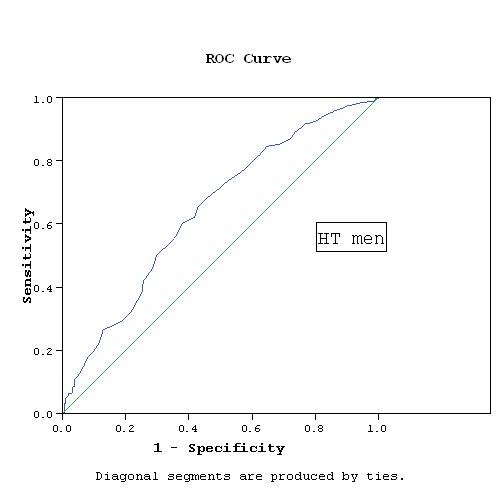
WC cutoff point by ROC curve in HT men. AUC = 0.668, p < 0.001 CI: 0.618- 0.718.